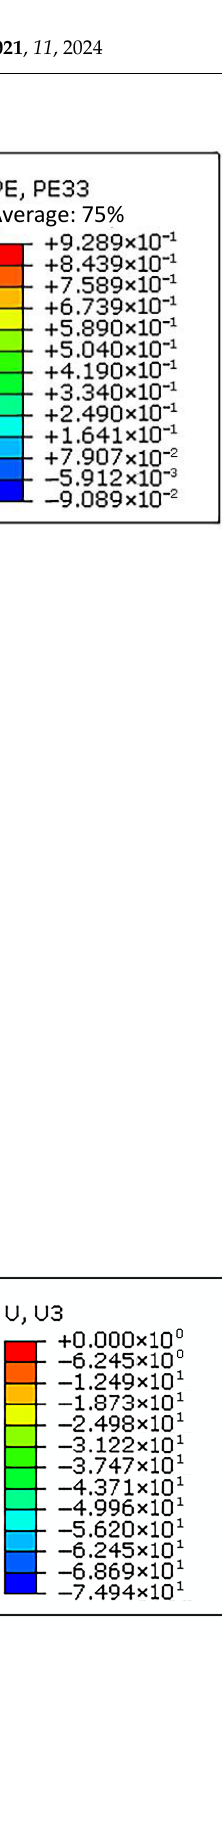
Figure 7. Displacement distribution (U3) in drawing.